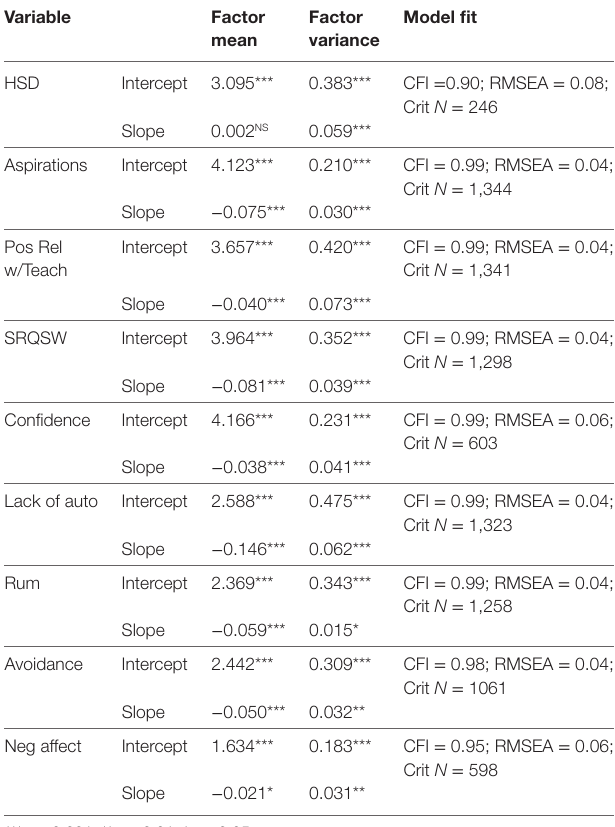
Table 2 | Unconditional latent growth model estimates of HSD and outcome